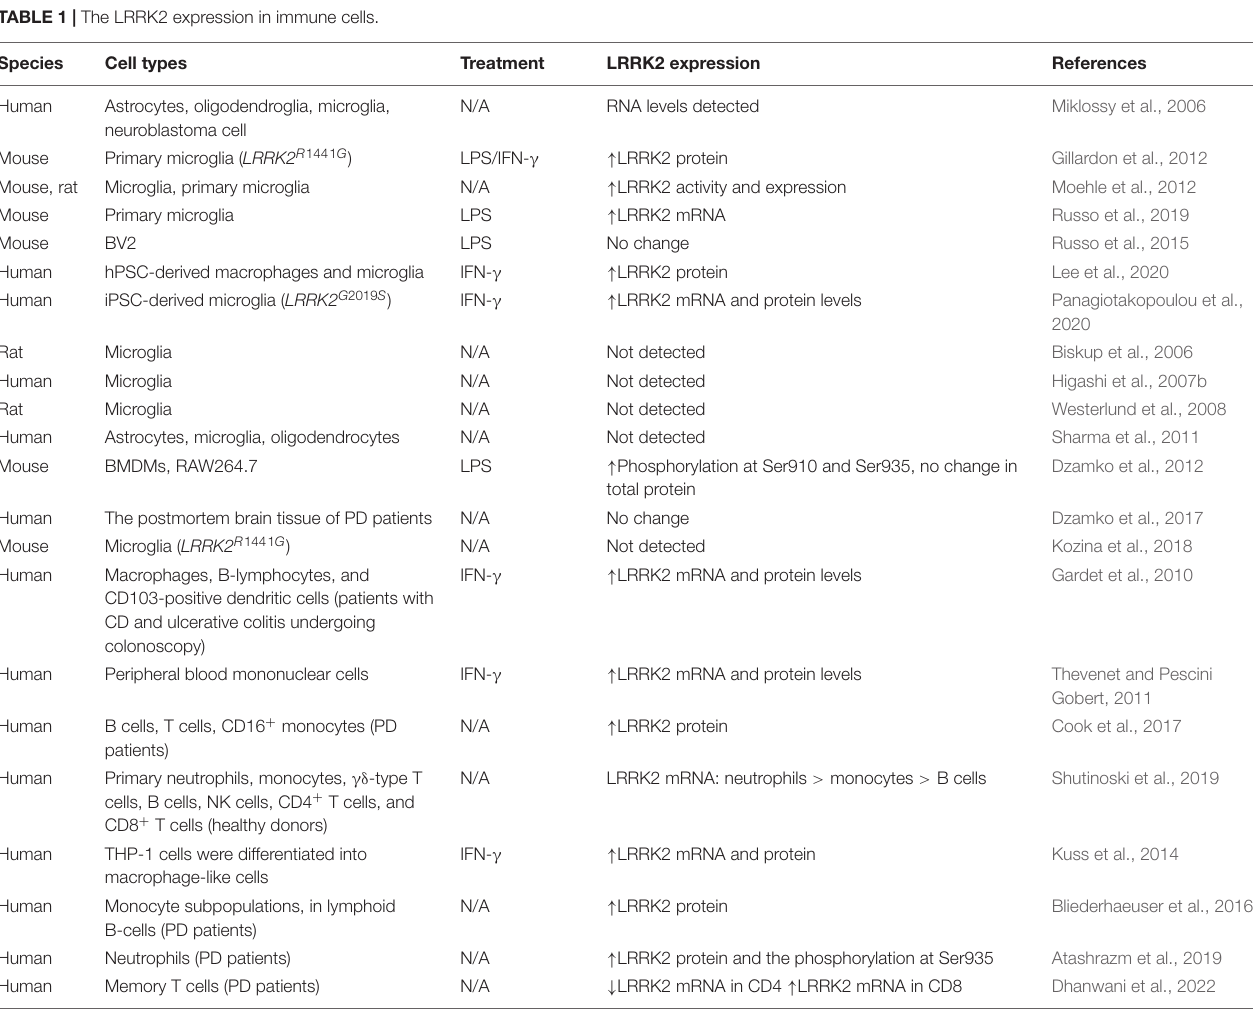
FIGURE 2 | The domain structure of the LRRK2 protein. The domains are divided into protein-protein interaction, GTPase, kinase, and protein-protein interaction according to their functions. PD-associated mutations mentioned in the review are depicted on top. TABLE 1 | The LRRK2 expression in immune